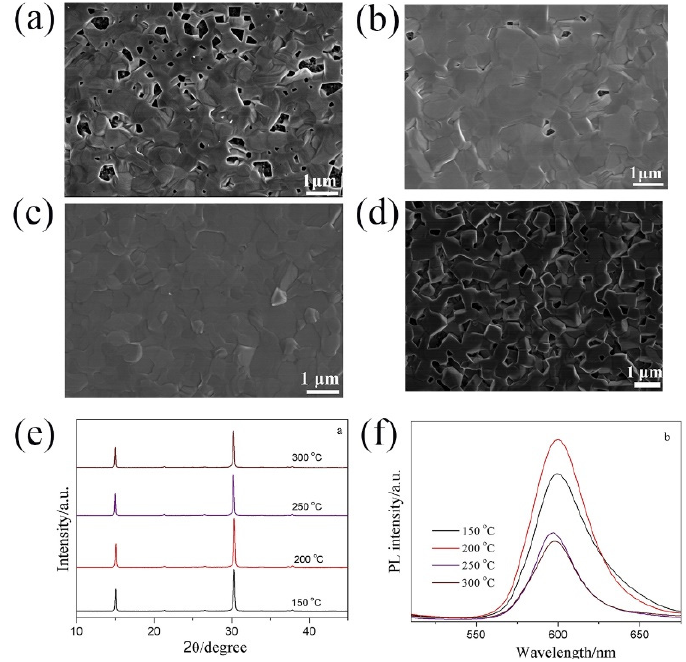
Figure 5. SEM images of CsPbIBr 2 perovskite films obtained at the substrate preheating temperatures of ( a ) 30 °C, ( b ) 50 °C, ( c ) 70 °C, and ( d ) 90 °C. ( e ) XRD patterns and ( f ) PL spectra of CsPbIBr 2 perovskite films formed at different preheating temperatures. Reproduced with permission [75]. Copyright 2020, Elsevier Inc. Publications. To reduce the nonradiative recombination centers in CsPbIBr 2 films, doping with